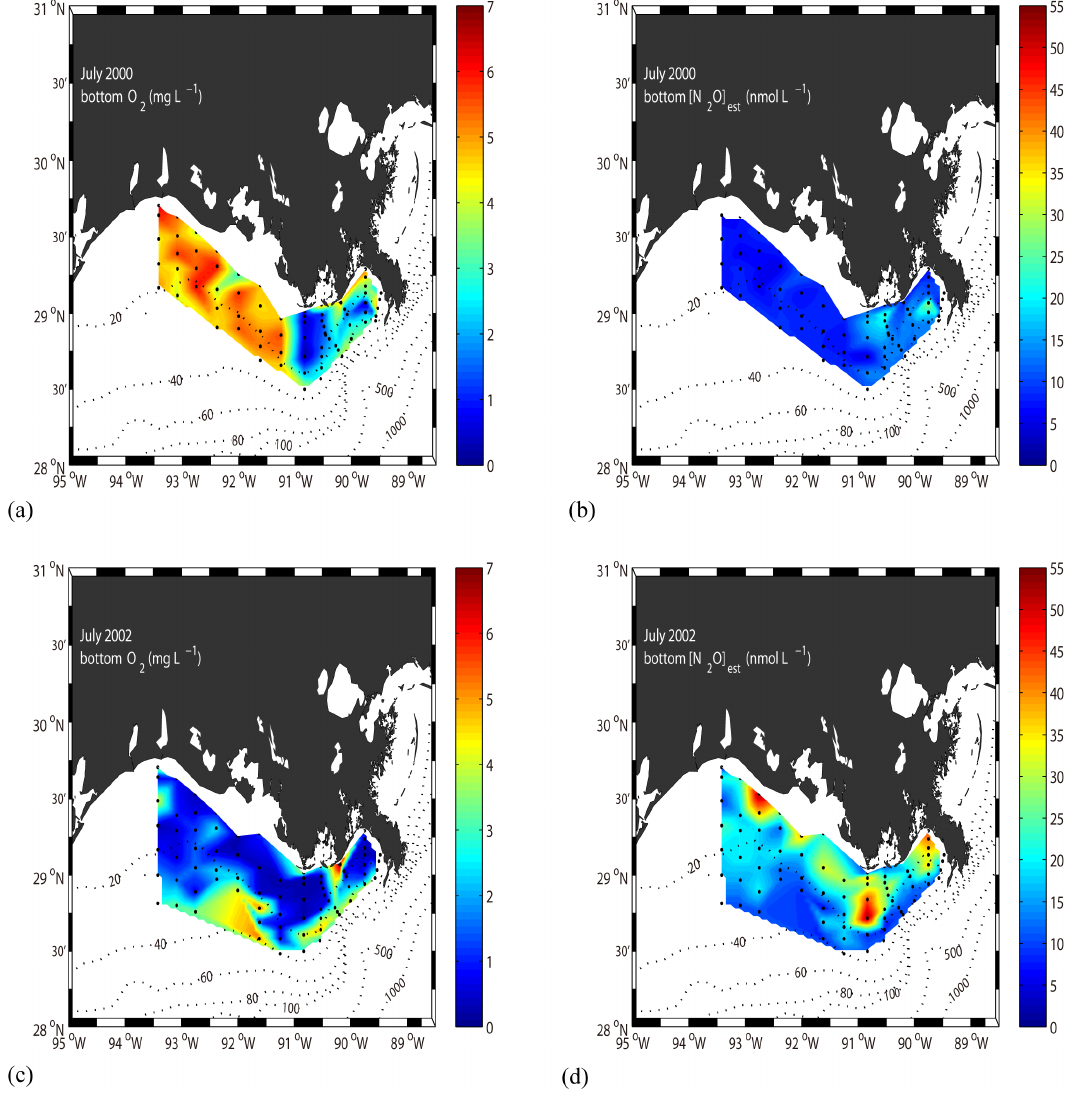
Fig. 5. Distributions of observed bottom-water O 2 and estimated bottom-water N 2 O concentrations in July 2000 and 2002, representing min. and max. hypoxic areal extent during the study period, respectively. (a) and (b) indicate bottom-water O 2 and N 2 O spatial distributions in July 2000. (c) and (d) denote bottom-water O 2 and N 2 O spatial distributions in July